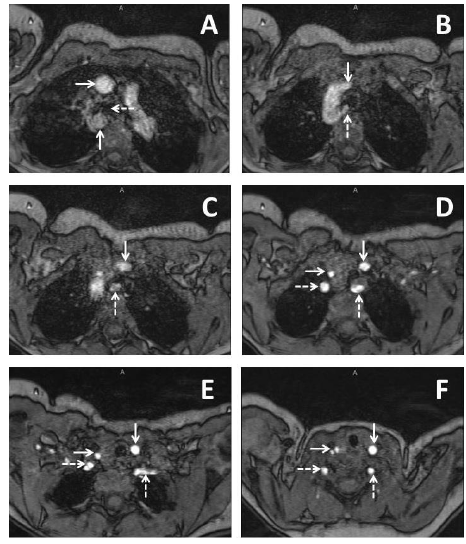
Figure 1. Imaging from a three months old baby girl with DiGeorge syndrome who had some issues with feeding. Series of axial slices from magnetic resonance imaging presented in an inferior to superior progression. Panel A demonstrates a right sided aortic arch with the ascending aorta (solid horizontal arrow) coursing anterior to the right bronchus (dashed horizontal arrow) and the descending aorta (solid vertical arrow) coursing immediately posterior to the right bronchus; Panel B demonstrates the left common carotid (solid vertical arrow) as the first branching head and neck vessel and arises from the ascending aorta. An aberrant left subclavian artery (dashed vertical arrow) is seen as the last branching head and neck vessel and arises from the descending aorta; Panel C demonstrates the course of the left common carotid (solid vertical arrow) and aberrant left subclavian artery (dashed vertical arrow); Panel D demonstrates bifurcation of the brachiocephalic trunk into the right common carotid (solid horizontal arrow) and the right subclavian artery (dashed horizontal arrow). The left common carotid (solid vertical arrow) and the left subclavian artery (dashed vertical arrow) are seen demonstrated as well; Panel E demonstrates the right vertebral artery arising from the right subclavian artery (dashed horizontal arrow). The right common carotid (solid horizontal line), left common carotid (solid vertical arrow, and aberrant left subclavian (dashed vertical arrow) are also demonstrated; Panel F demonstrates early bifurcation of the right common carotid into the right internal and external carotid arteries (solid horizontal arrow). The right vertebral artery (dashed horizontal arrow), the left common carotid (solid vertical arrow), and the left vertebral artery are also demonstrated (dashed vertical arrow).